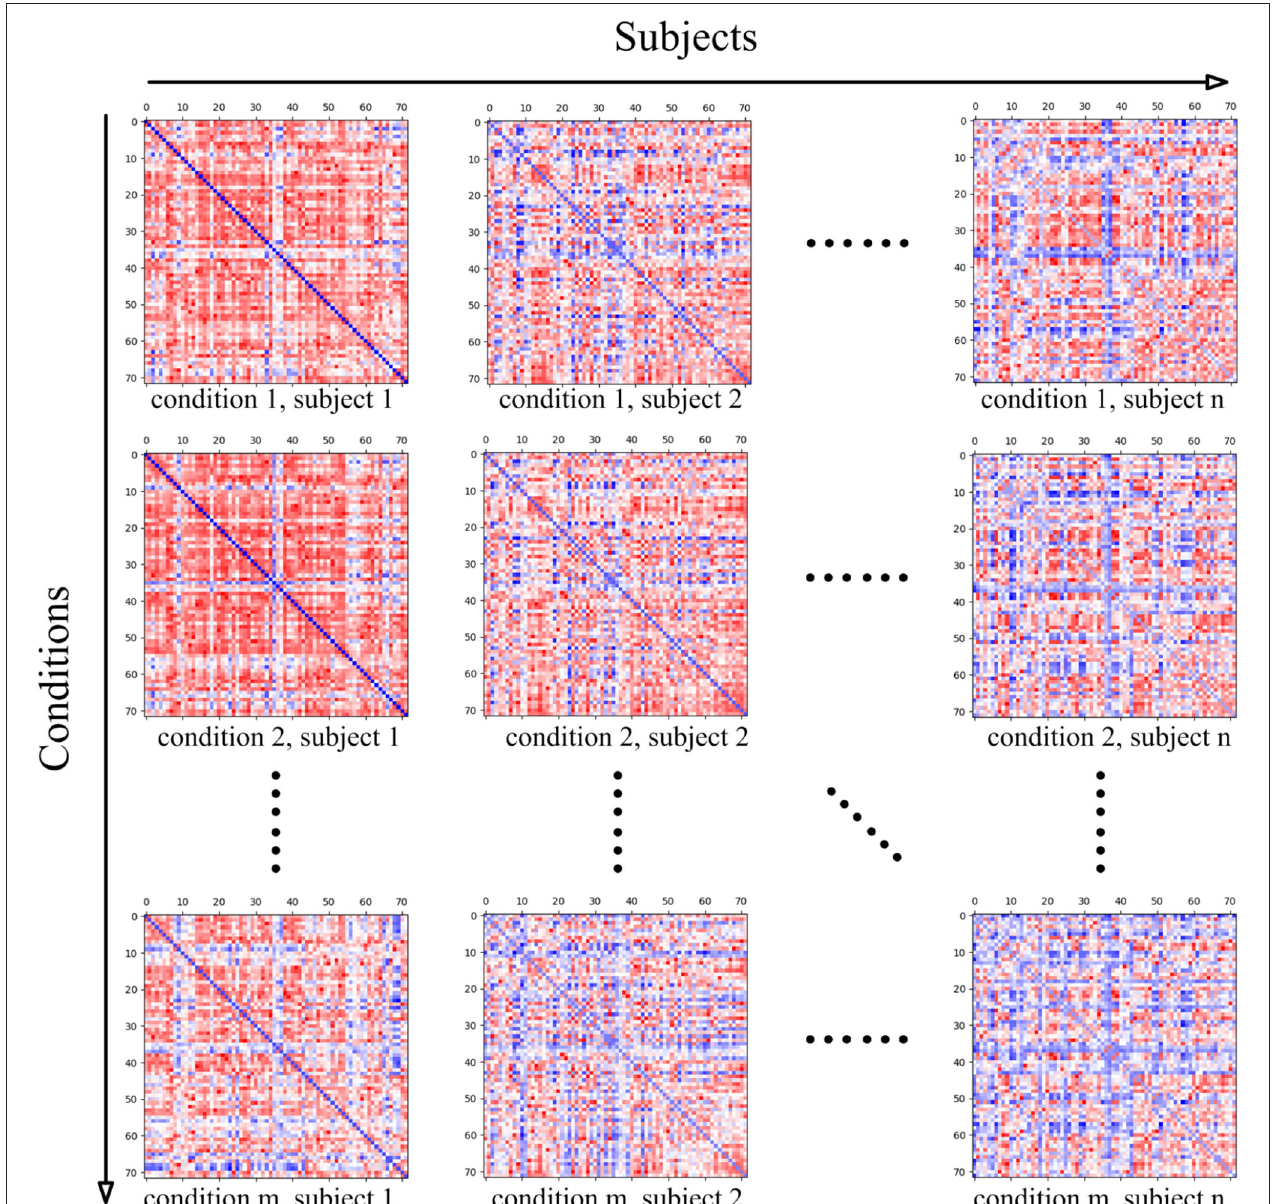
FIGURE 4 | The four-dimensional matrix MatricesConditions , where the first dimension represents the conditions in the cognitive task, and the second dimension represents the subject. When the condition and subject are set, the obtained two-dimensional matrix stands for the brain functional connectivity matrix of the subject under the current cognitive task condition, and the shape of the two-dimensional matrix is determined by the ROIs’ number of the adopted cognitive network.